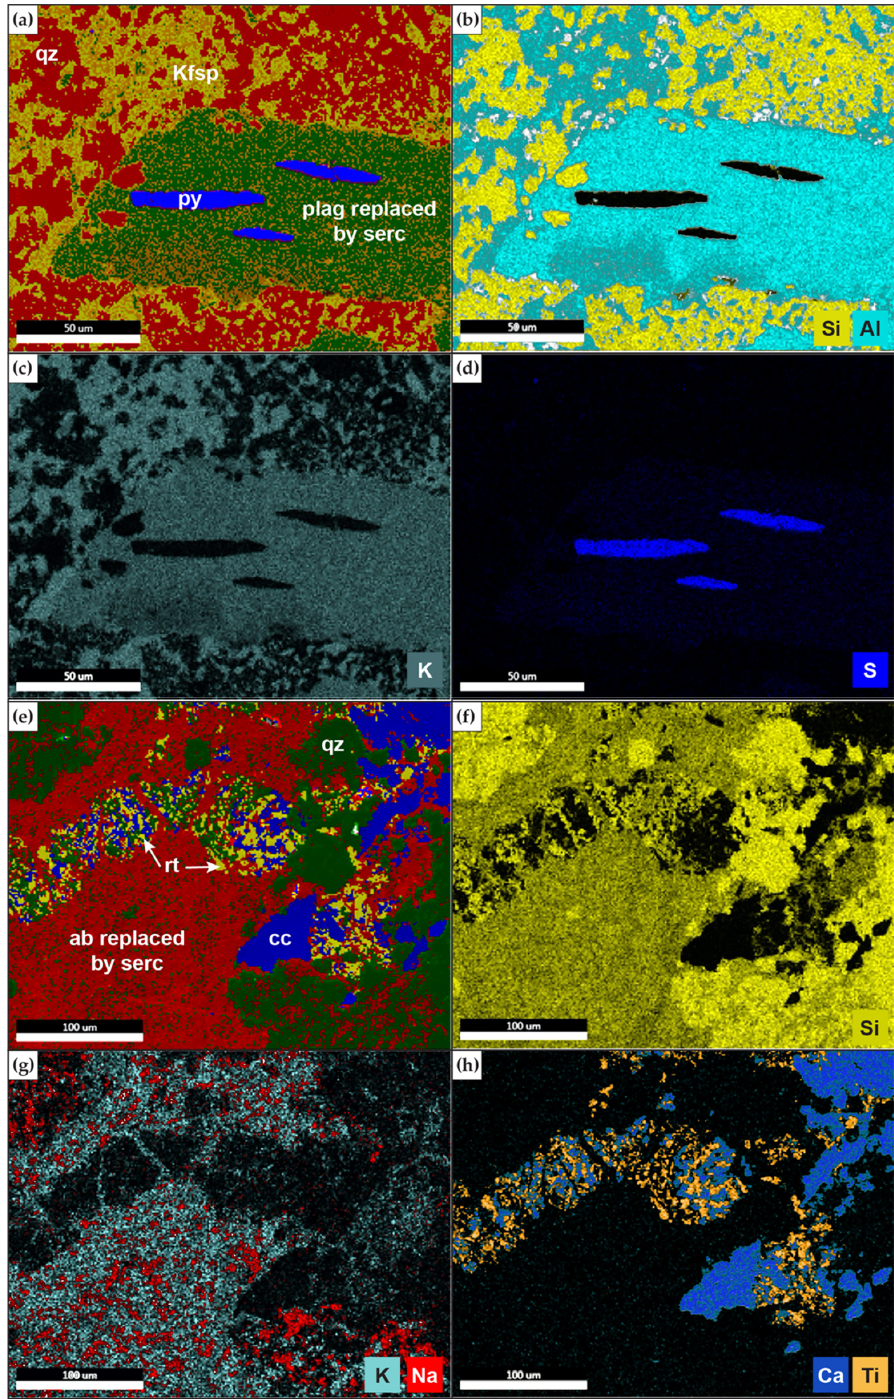
Figure 14. Elemental maps, ( a – d ) sericitization of plagioclase with orthoclase rim and pyrite inclusions (S825792, BR-79), ( a ) elemental map of alteration phases present, ( b ) Si and Al highlighting occurrence of quartz, K-feldspar and sericite, ( c ) K highlighting occurrence of K-feldspar and sericite both replacing plagioclase, ( d ) S highlighting pyrite inclusions within sericite, ( e – g ) sericitization of albite surrounded by quartz, calcite and rutile (S825756, BR-74), ( e ) elemental map of alteration phases present, ( f ) Si highlighting occurrence of quartz (bright lime), albite and sericite (darker lime), ( g ) K and Na highlighting occurrence of albite (Na) that is almost completely replaced by sericite (K), ( h ) Ca and Ti highlighting intergrowth of secondary calcite (blue) and rutile (orange) between sericite and quartz. Abbreviations: ab—albite, cc—calcite,